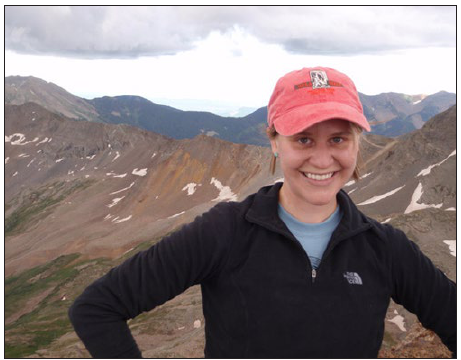
Figure 3: Rachel King, Lecturer Cultural Her- itage studies at the IoA (Photo: Rachel